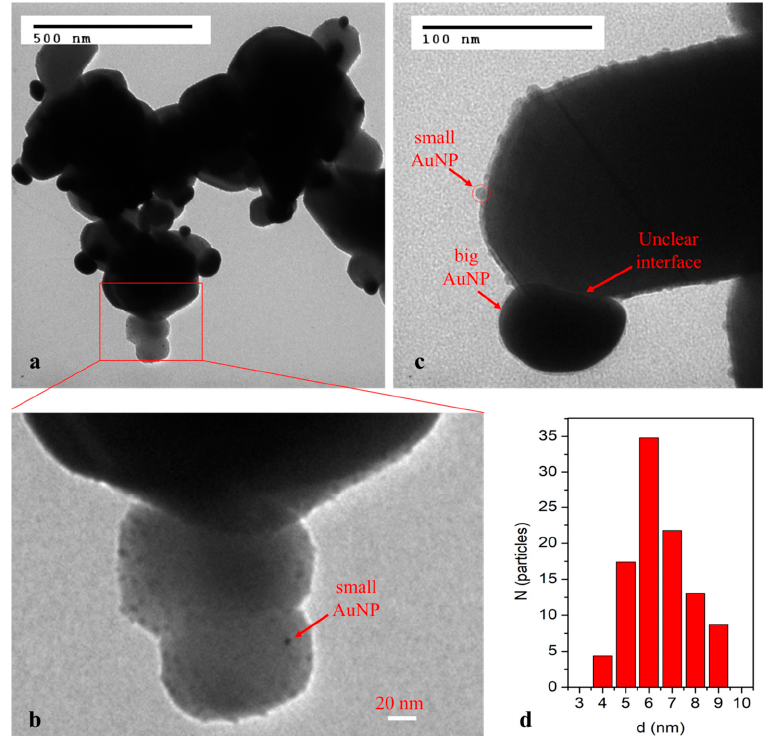
Figure 8. TEM images ( a ) of the treated Au / TiO 2 nanocomposite produced by the plasma–liquid interaction method with the precursor concentration of 0.06 mM. Magnification of TEM images elucidating ( b ) the submerging of small gold nanoparticles into TiO 2 surface and ( c ) the close contact between gold nanoparticle and TiO 2 surface. The particle size distribution histogram ( d ) of small gold nanoparticles of the same sample.